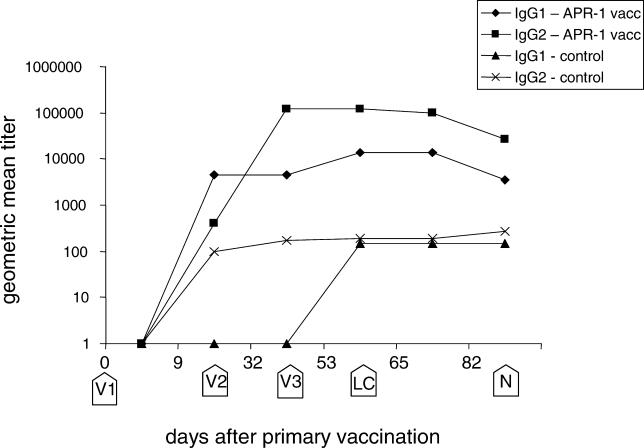
The Geometric Mean Titers of the IgG1 and IgG2 Antibody Responses of Dogs Vaccinated with Recombinant Ac-APR-1 Formulated with AS03 or AS03 AloneLC, day on which dogs were challenged with hookworm L3; N, day of necropsy; V1, V2, and V3, days on which animals were vaccinated.